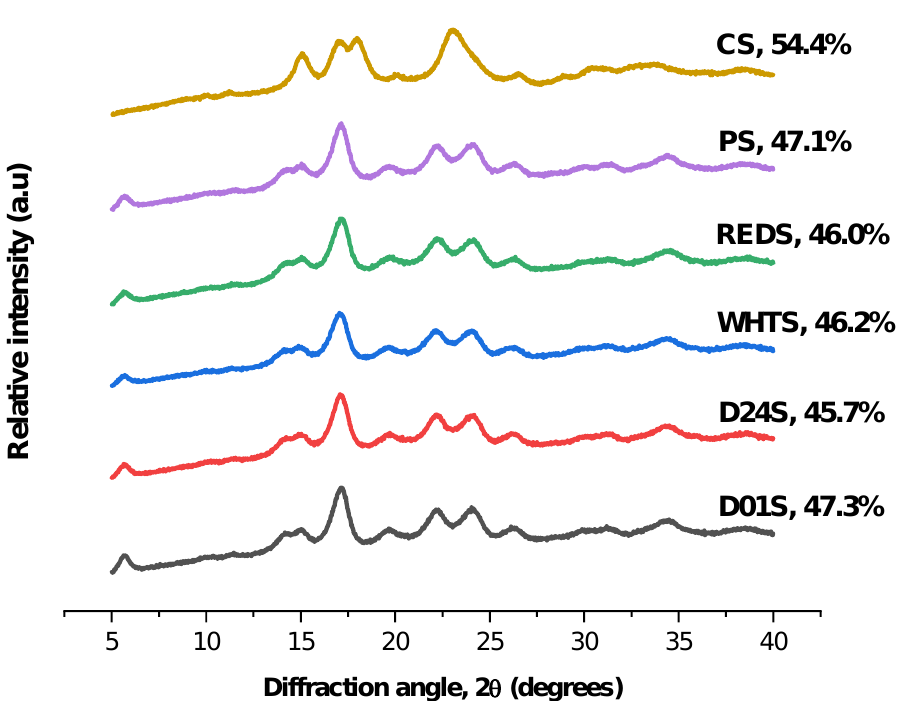
Figure 2. The XRD pattern of starches from four cultivars of anchote. Potato and cassava starches are included as references. D01S = Desta 01 starch, D24S = Desta 24 starch, WHTS = white starch, REDS = red starch, PS = potato starch, and CS = cassava starch. The degree of crystallinity for all samples is shown on the graph.